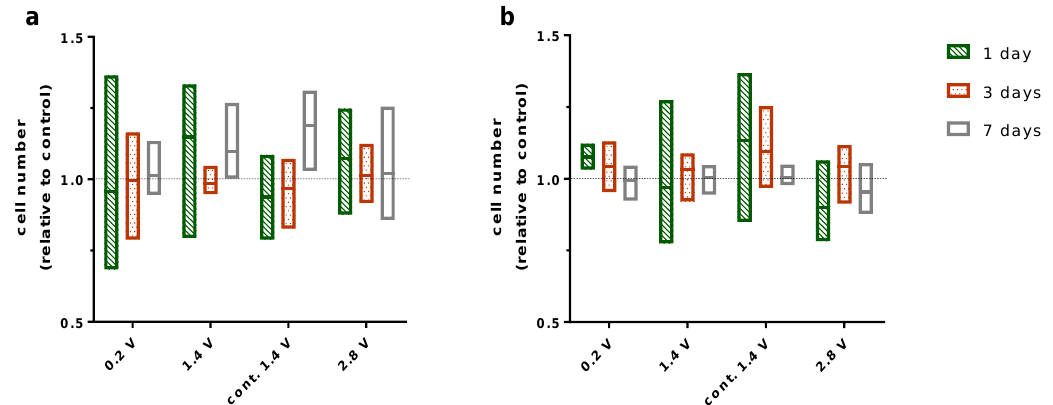
Figure 2. Cell number of osteoblasts cultured one, three, and seven days with and without electrical stimulation counted via ImageJ. Cell number is displayed relative to the control for each time point. For this experiment, 0.2V, 1.4 V, and 2.8 V groups were stimulated 3 × 45 min per day while the cont. 1.4 V group was stimulated continuously with 1.4 V. Cells grown on Ti6Al4V electrodes ( a ) and collagen-coated coverslips ( b ). n = 3.